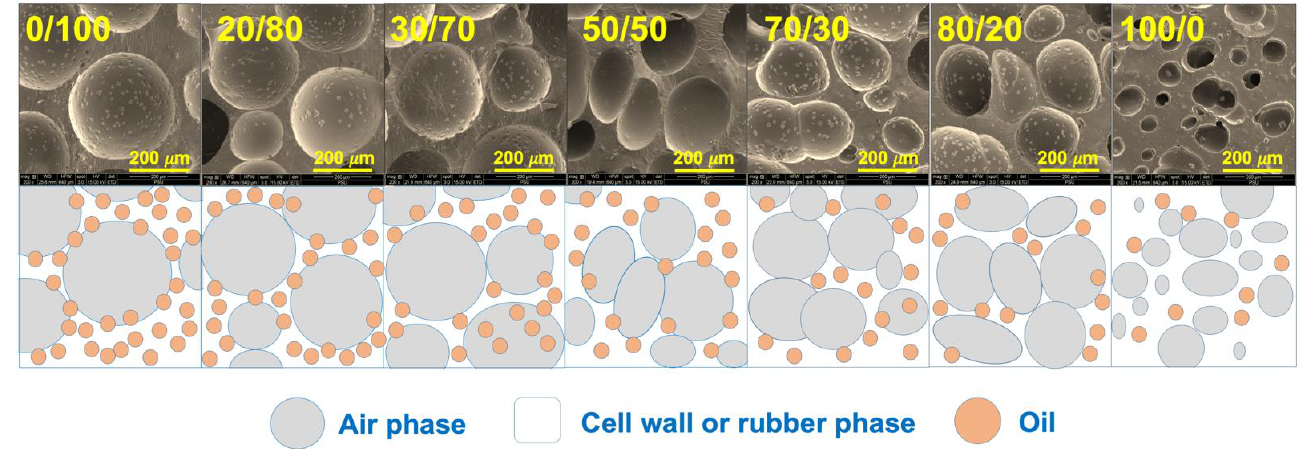
Figure 7. Swelling schematic of oil penetrant through the SR/NR blends.